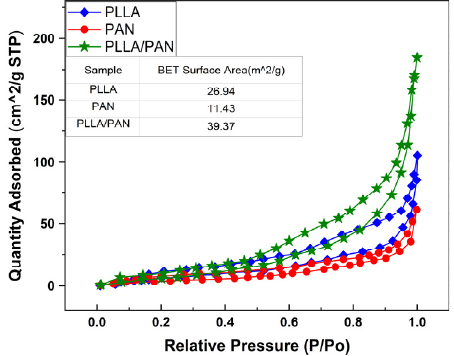
Figure 5. N 2 adsorption − desorption isotherms graphs of fibrous membranes.